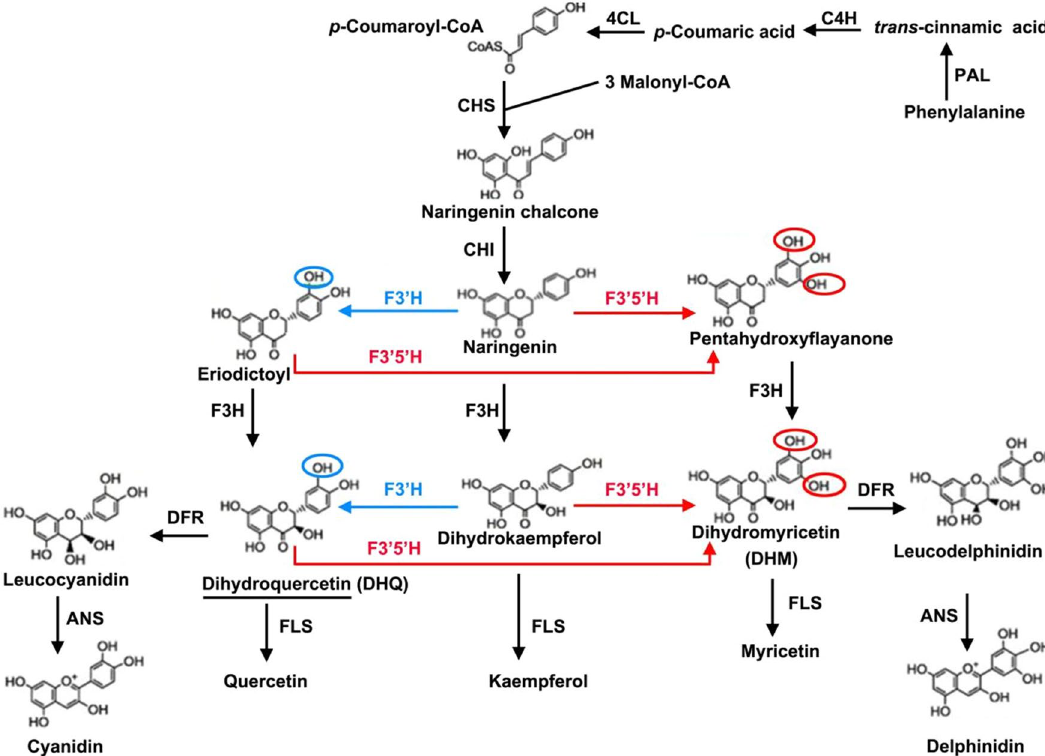
Figure 9. The main flavonoids biosynthesis pathway in A. grossedentata . The pathway was referenced to ko00940, ko00941, and ko00944 in the KEGG pathway. Abbreviations are as follows: PAL, phenylalanine ammonialyase; C4H, cinnamate 4- hydroxylase; 4CL, 4-coumarate-CoA ligase; CHS, chalcone synthase; CHI, chalcone isomerase; F3’H, flavonoid 3’- hydroxylase; F3’5’H, flavonoid 3’5’-hydroxylase; F3H, flavonoid 3-hydroxylase; DFR, dihydroflavonol 4-reductase; FLS, flavonol synthase; ANS, anthocyanidin synthase; DHM, dihydromyricetin. The single underlined portions represent dihydroquercetin (DHQ). The red lines representation of the reactions catalyzes by F3’5’H. The blue lines representation of the reactions catalyzes by